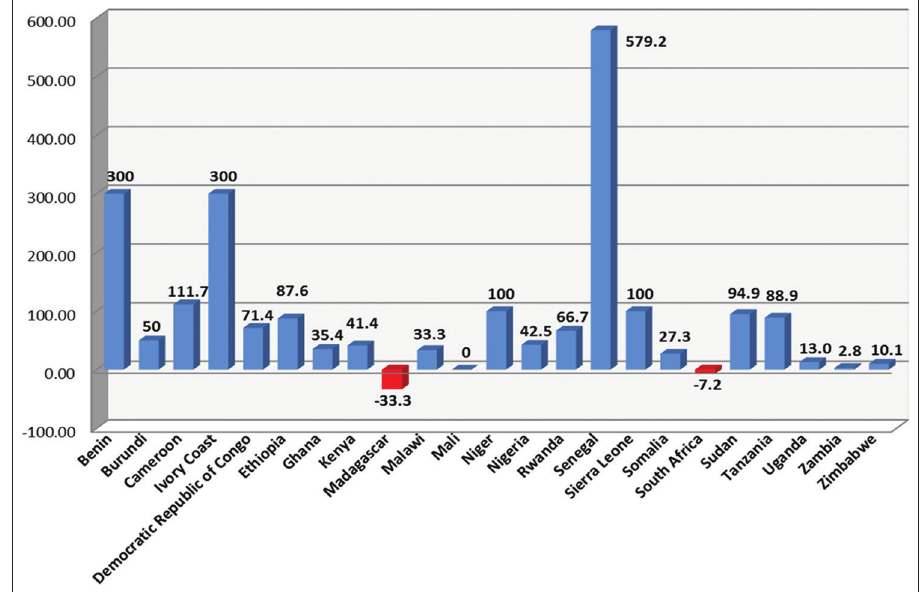
Figure 2 : Percentage change in the number Sub-Saharan African educated international medical graduates in the United States of America between 2005 and 2015, data source.